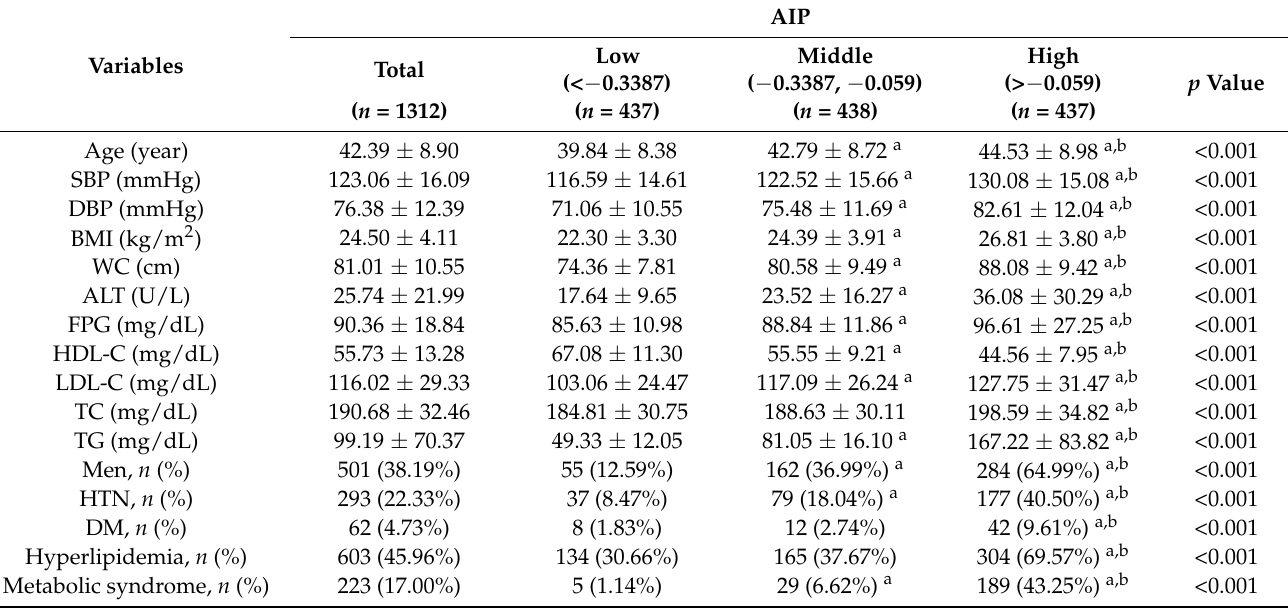
Table 2. Clinical characteristics according to AIP tertiles among the study population.